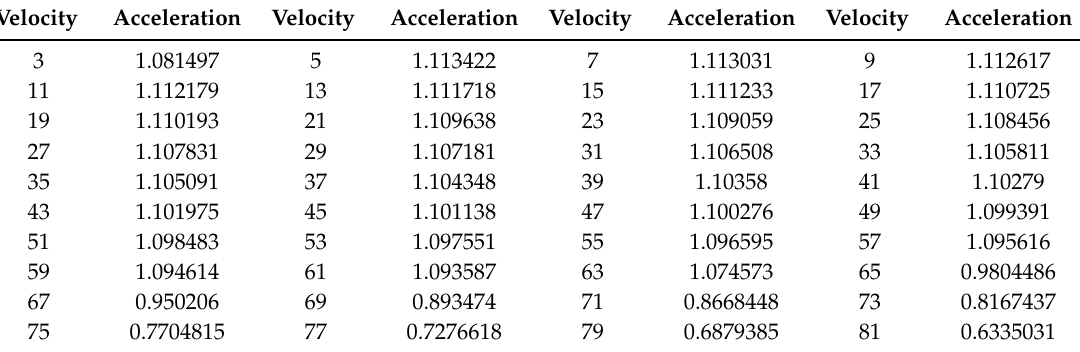
Figure 5. Comparison of the original data and the output of the proposed model. Table 5. Relationship between the velocity and the acceleration of